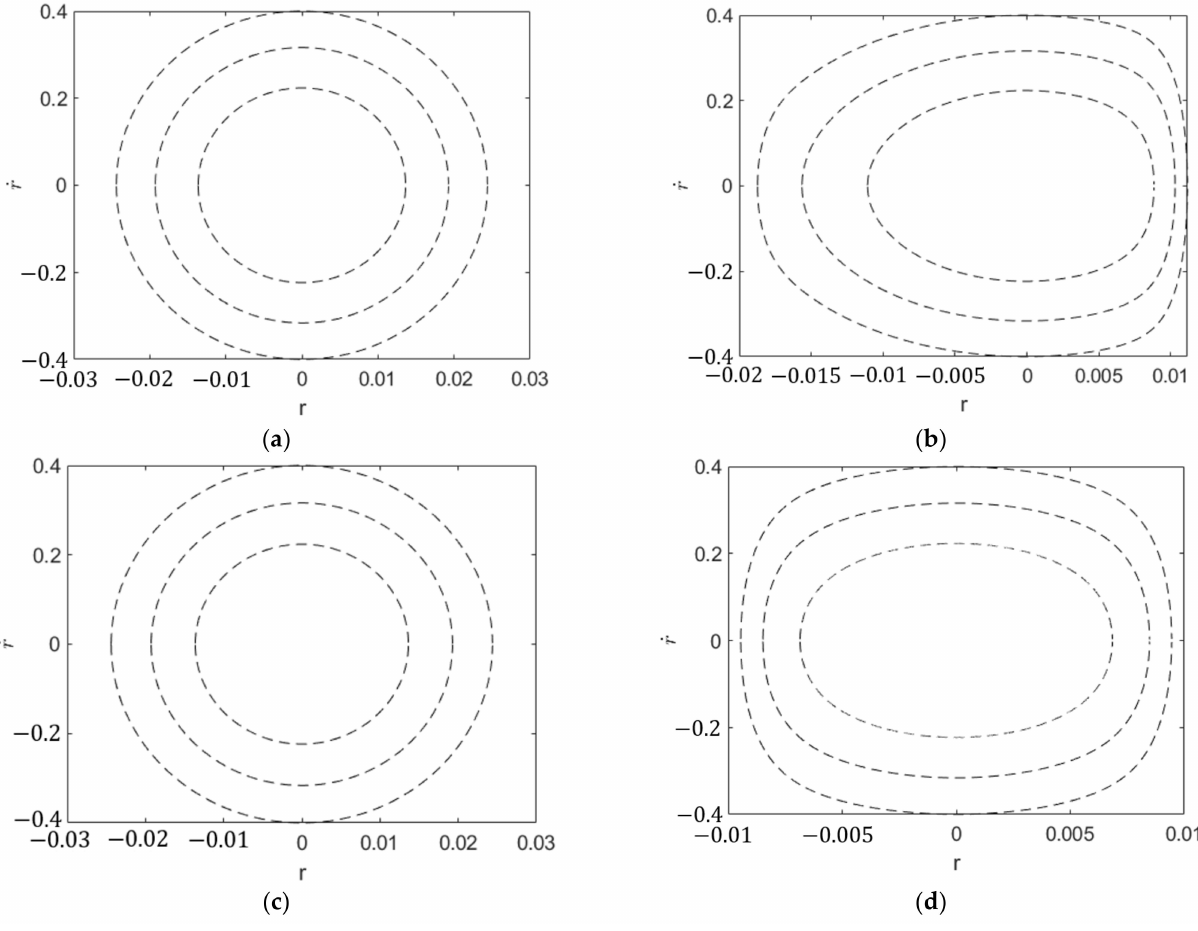
Figure 13. Phase portraits for a single magnet case ( a , b ) and double magnet case ( c , d ) for a gap size of ( a , c ) 6 mm and ( b , d ) 5.66